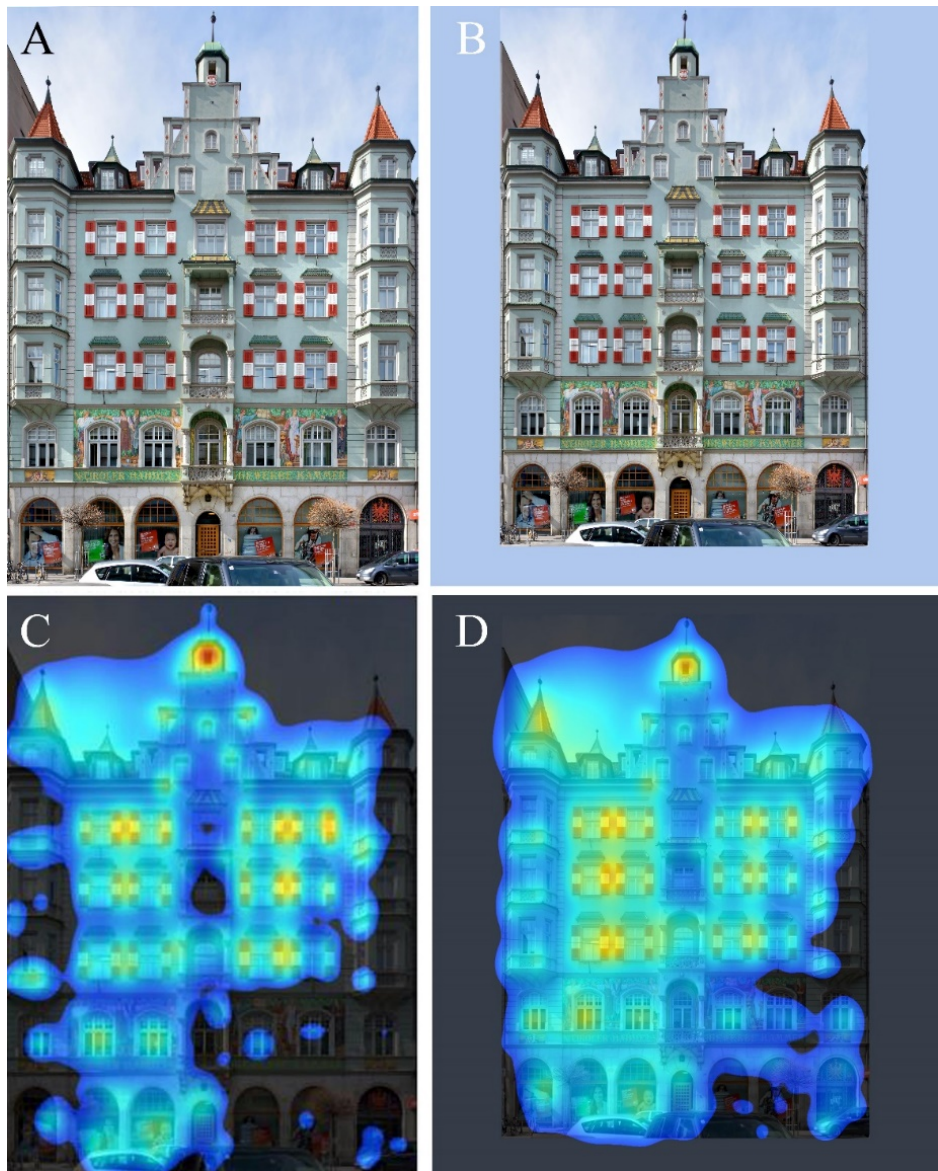
Figure 16. The building of the Tyrolean Chamber of Commerce and Industry in Innsbruck, Austria, built in the 1900s, in a tightly cropped image ( A ), with its eye-tracking simulation heatmap ( C ). The same image after a frame has been added ( B ) provides a more accurate eye-tracking simulation heatmap ( D ).